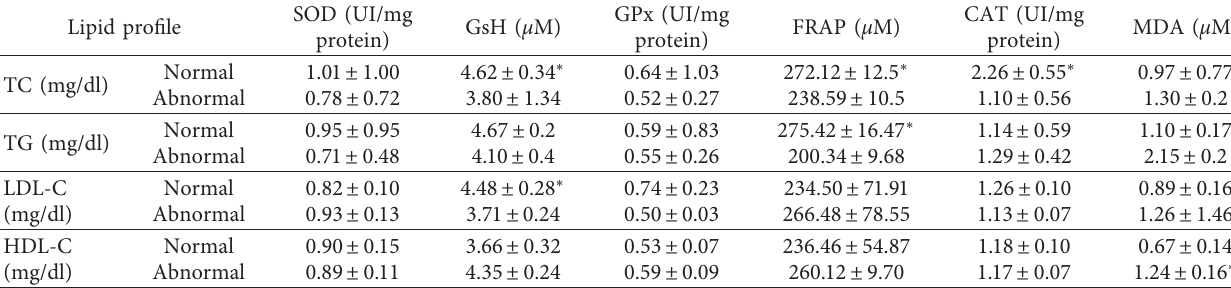
Table 3: Effect of lipid profile on some markers of oxidative stress.